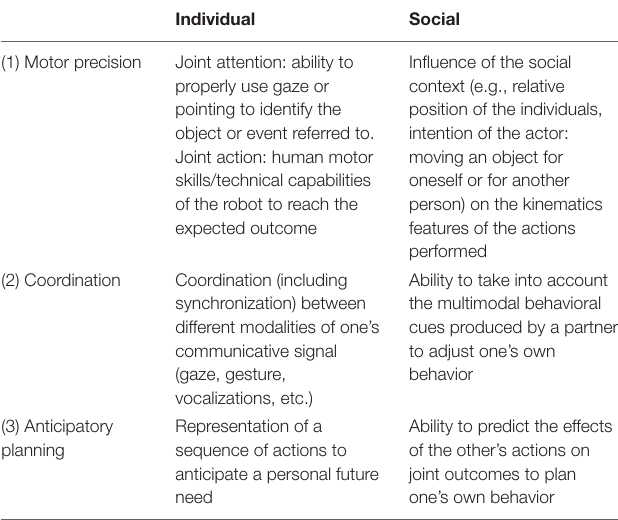
TABLE 1 | Complexity in HRI: illustration of three dimensions at the individual and social levels (adapted from Cochet and Byrne, 2015). Individual